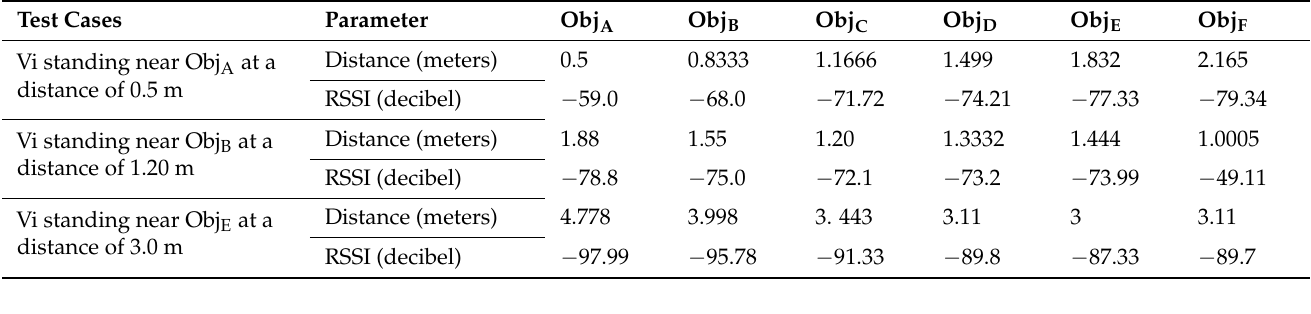
Table 2. Distance (meters) and location (decibels).